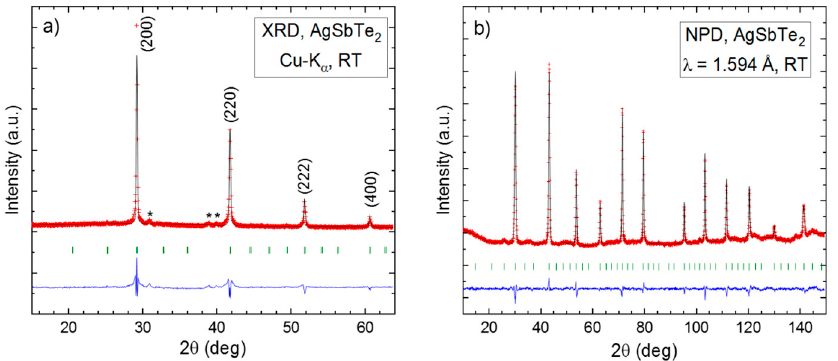
Figure 1. ( a ) XRD and ( b ) NPD patterns of AgSbTe 2 at room temperature. The experimental points are shown in red, the calculated model in black and the difference in blue. The star denotes the known impurities detected in the X-ray pattern.